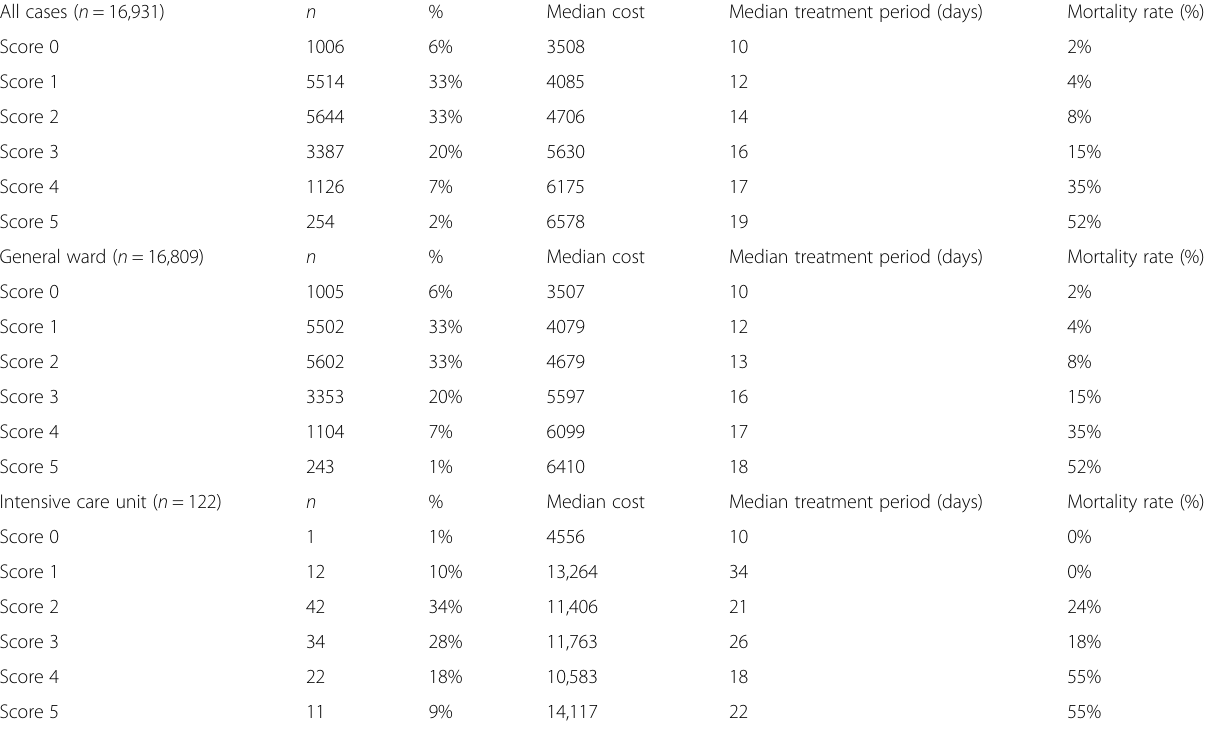
Table 2 All-cause total treatment costs according to severity and community-acquired pneumonia treatment setting All cases ( n = 16,931)